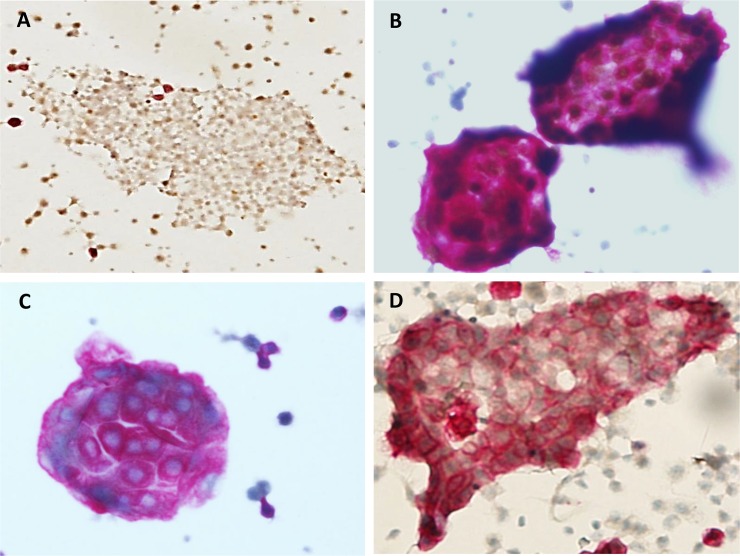
Typical immunocytochemistry patterns of cluster in peritoneal suspensions using LBC.(A) Two-dimensional sheet with a dual-negative (CK7-/PAX8-) pattern represents mesothelial cells. (B) Three-dimensional large clusters with dual staining for nuclear PAX8 and cytoplasmic CK7. (C) Three-dimensional large clusters with staining for cytoplasmic CK7, but no nuclear PAX8 staining. (D) Two-dimensional sheet with staining for CK7 indicates that the cells are not mesothelial cells.